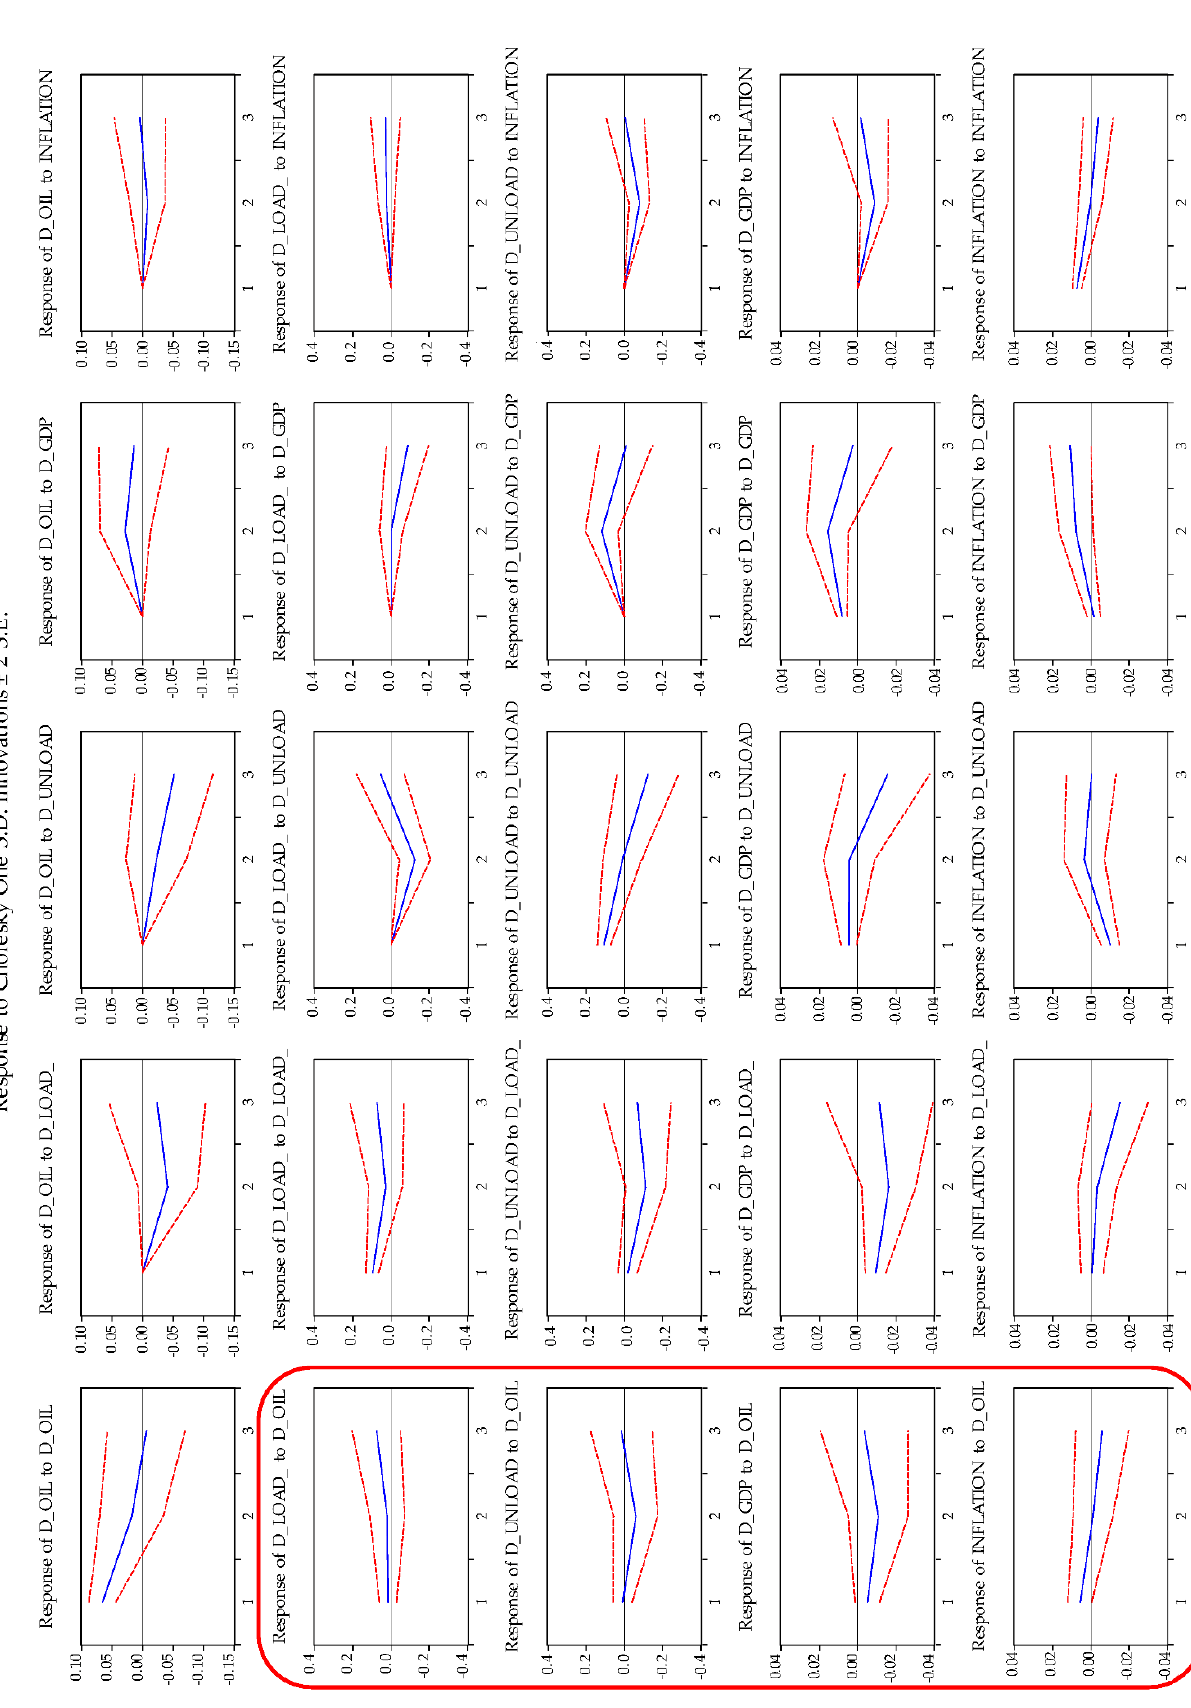
Figure 3. Impulse response functions: variable increments (model B). Red line—95% confidence